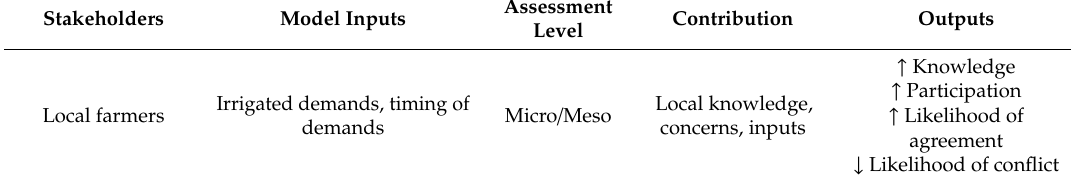
Table 3. Stakeholder model inputs, contributions and outputs at various assessment levels within the Pangani River Basin. Directions of arrows indicate increases ( ↑ ) and decreases ( ↓ ) of